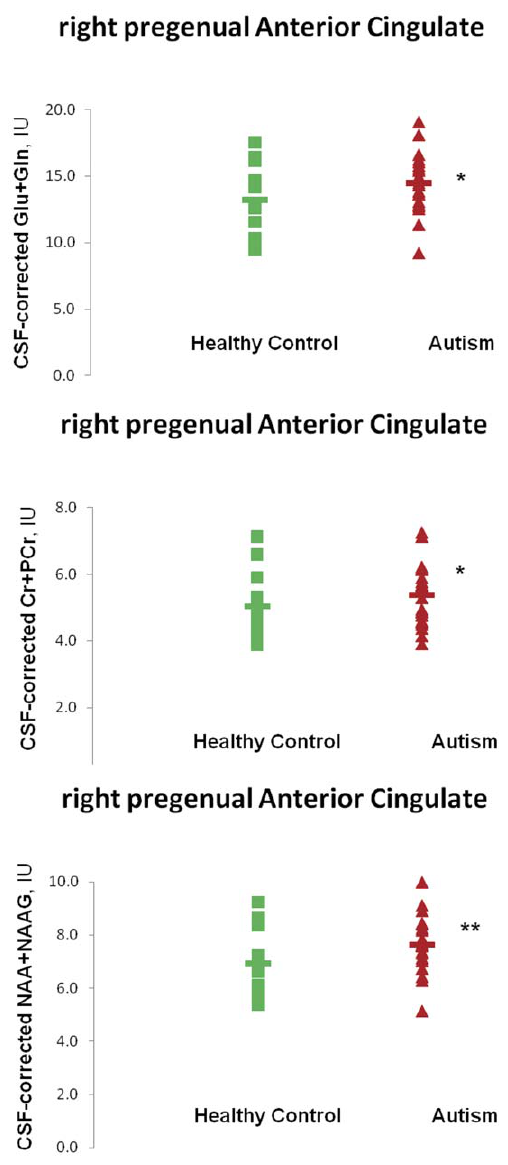
Figure 5. LCModel-derived absolute metabolite levels in Institutional Units ( IU ) corrected for voxel CSF-content for subjects with ASD ( red triangles ) and healthy controls ( green squares ) in right pACC. Horizontal bars denote group means. Values are shown for glutamate + glutamine (‘‘Glx’’; top ), creatine + phosphocreatine ( middle ), and N -acetyl-aspartate + N -acetyl-aspartyl- glutamate. Note elevations of all three metabolites in subjects with ASD . * p , 0.05, ** p , 0.01 (ANCOVA following R-ANCOVA of rank- transformed, therefore non-parametric data.) Experiment 2.